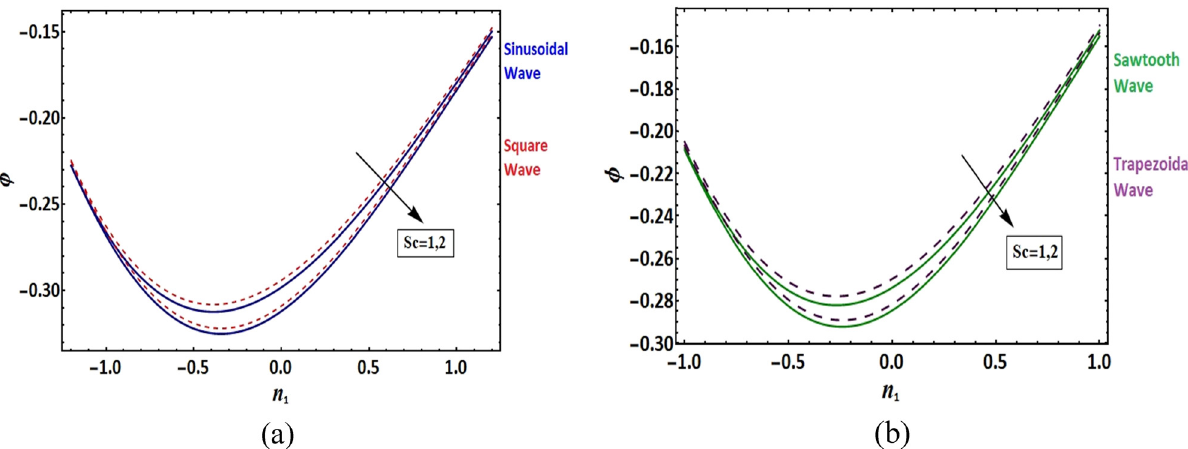
= 0.1, A = 2, Sr = 0.5 A = 1, Br = 0.5, K = 2, K = 3, ϵ 0.2 = , 1 3 3 1